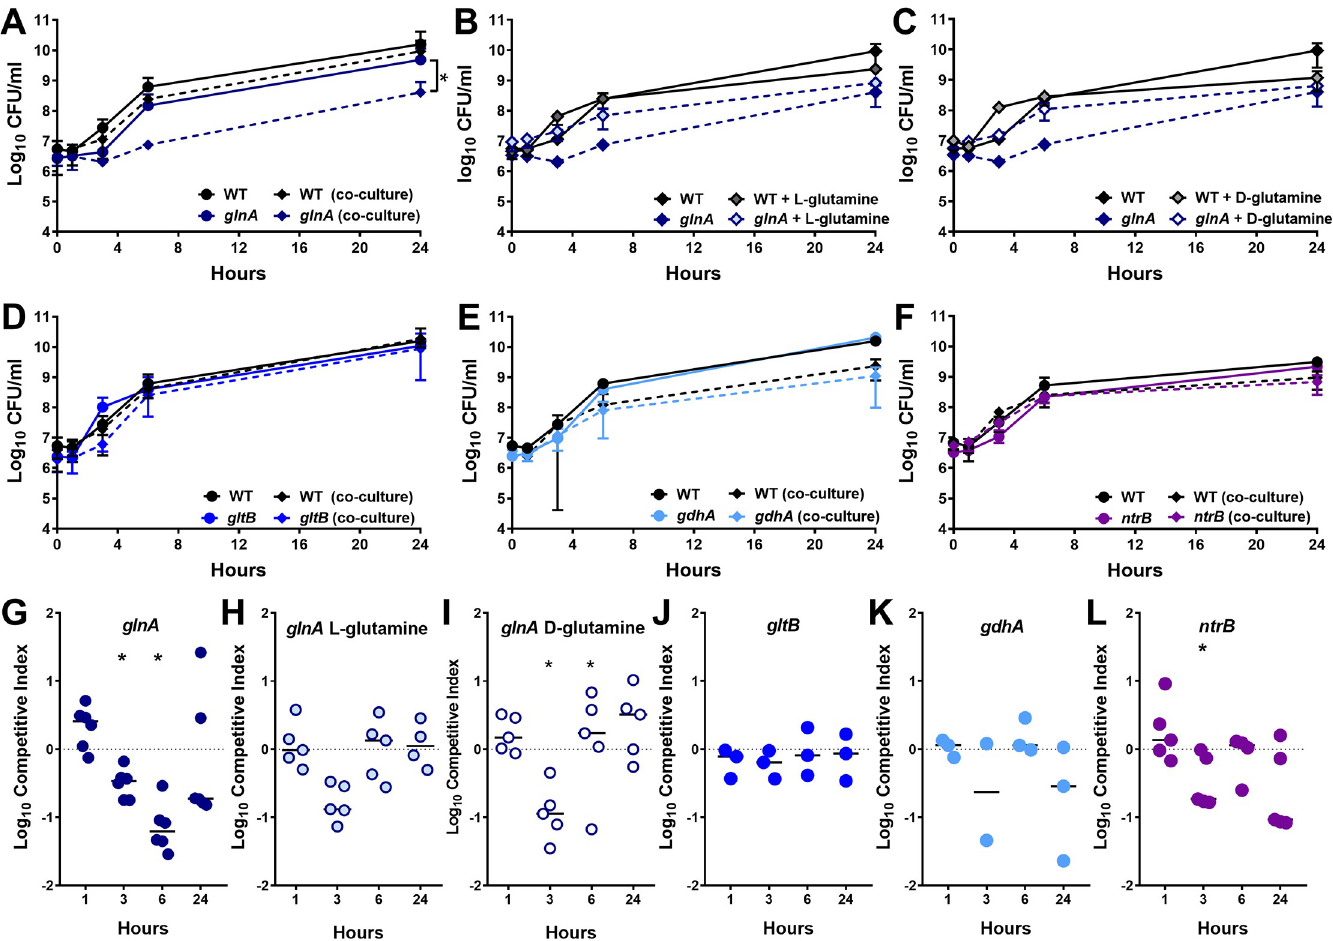
Fig 9. Nitrogen assimilation does not contribute to fitness in serum ex vivo . 50% naive mouse serum was inoculated with 1x10 6 CFU wild-type P. mirabilis , an isogenic mutant, or a 1:1 mixture of wild-type P. mirabilis and isogenic mutant (co-culture). The following mutants that exhibited significant fitness defects in the liver and/or spleen during bacteremia were included: glnA (A), gltB (G), gdhA (I) and ntrB (K). Additionally, the growth of glnA in 50% mouse serum with or without supplementation of L-glutamine (C) or D-glutamine (E) was assayed. Cultures were incubated statically at 37˚C with 5% CO2 and sampled at 0, 1, 3, 6, and 24 hours for enumeration of CFUs on LB agar with and without kanamycin. Error bars represent the mean ± standard deviation from three to five biological replicates. � P < 0.05 as determined by two-way ANOVA. (B, D, F, H, J, L) A competitive index (CI) was calculated for the mutant at each time point from the ratio of mutant to wild-type colonization level at the time indicated divided by the ratio of mutant to wild-type at time zero (see Materials and Methods). Each data point represents the CI from an individual replicate. Solid lines represent the median. Dashed lines indicate a competitive index of 1, or a 1:1 ratio of mutant to wild-type. Error bars represent the mean ± standard deviation from three to five biological replicates. � P < 0.05 as determined by Wilcoxon signed rank test.